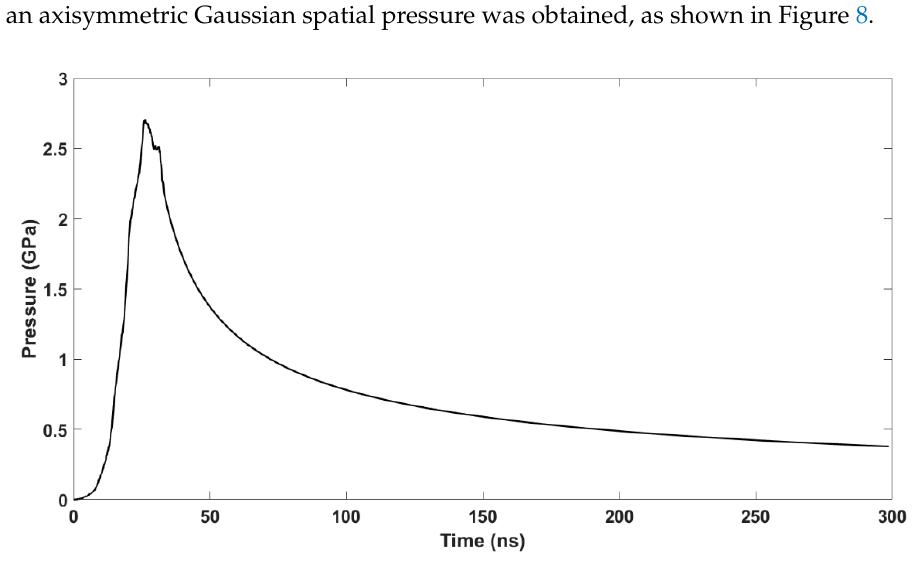
Figure 8. Variation of peak plasma pressure in time.